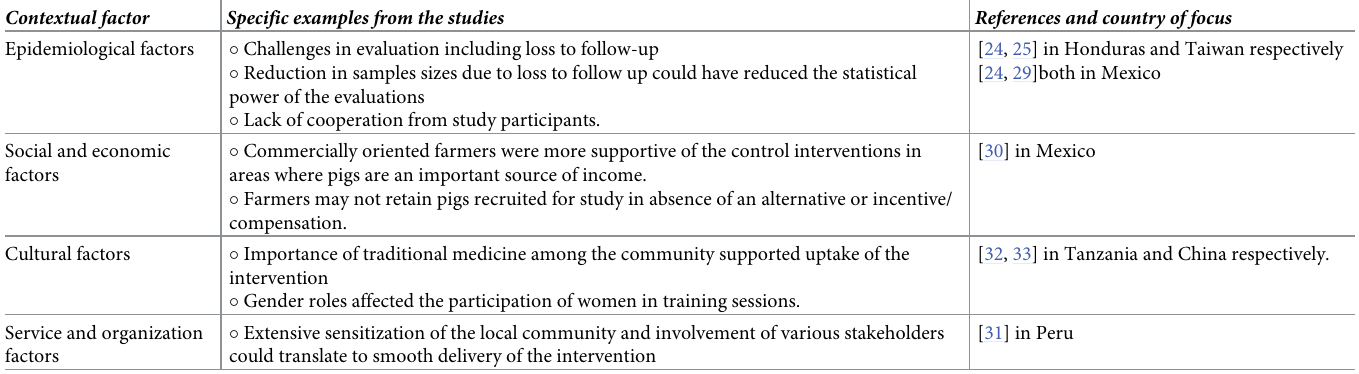
Table 2. Summary of contextual factors analysis for efficacy